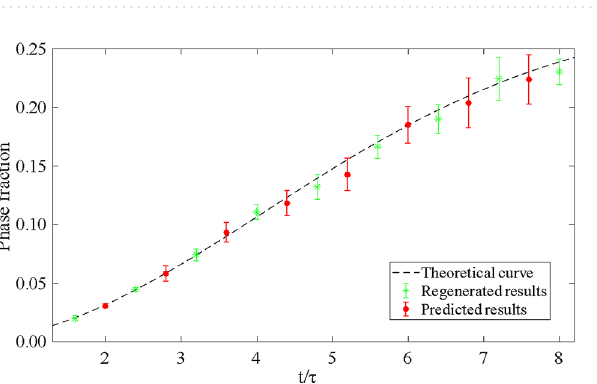
Figure 5. Using computer-generated micrographs to evaluate the accuracy of the RCWGAN-GP in regenerating and predicting microstructure of secondary phase grain growth. The processing parameter are a time series, t/τ = 1.6, 2.4, 3.2, 4.0, 4.8, 5.6, 6.4, 7.2 and 8.0. After training, RCWGAN-GP can regenerate micrographs that have similar microstructure features at the trained time series. We use RCWGAN-GP to predict the microstructure at a new set of time, (t/τ) = 2.0, 2.8, 3.6, 4.4, 5.2, 6.0, 6.8, and 7.6. The predicted micrographs showed the expected microstructure features during the secondary phase grain growth.